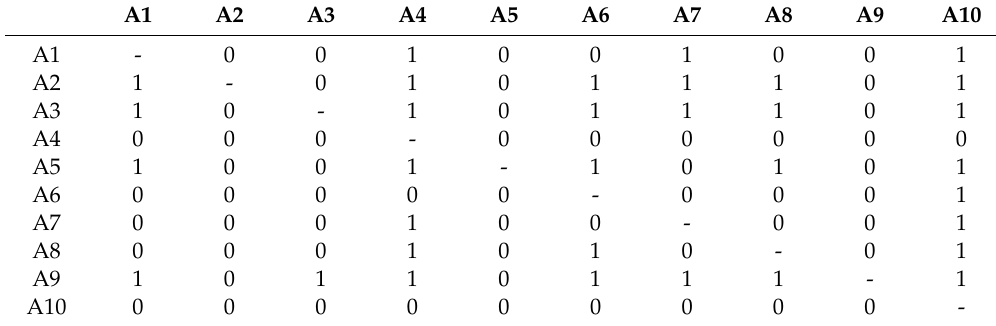
Table 26. The global matrix Z.